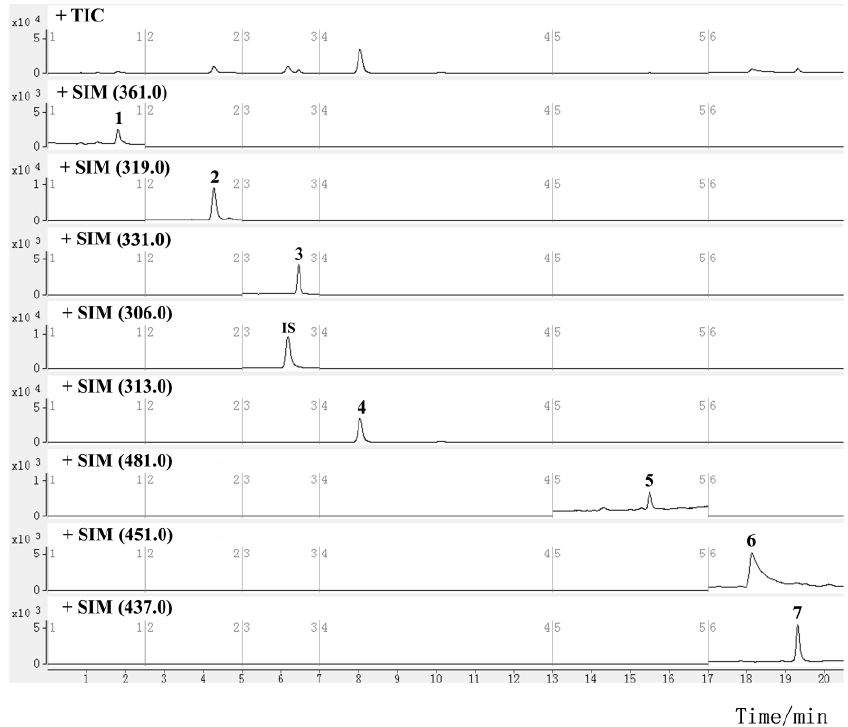
Figure 2. SIM chromatograms for investigated diterpenoids and triterpenoids in TGTs (sample S2, the peak numbers correspond to the compound numbers in Figure 1).